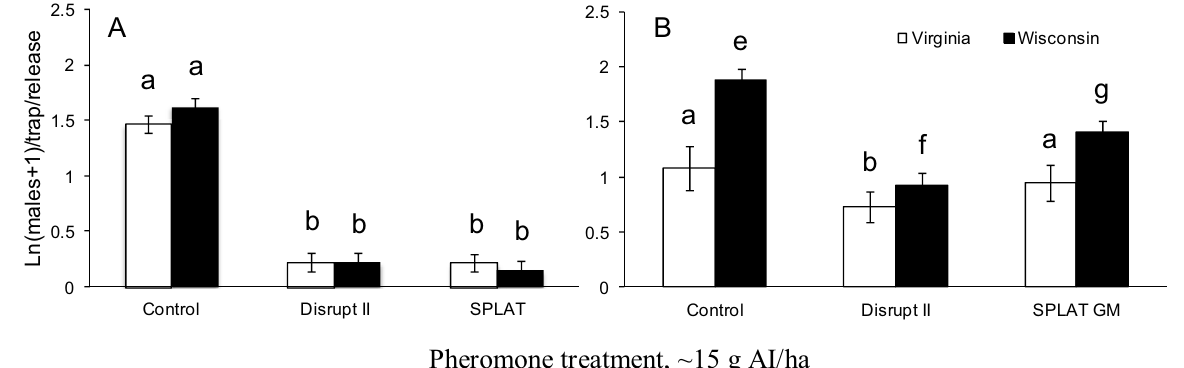
Figure 4. Male moth trap catch from pheromone-baited traps in the year of pheromone treatment ( A ) and one year after the pheromone treatment ( B ). Within (A), bars with the same letters are not significantly different, within (B), for each region (VA or WI), bars with the same letters are not significantly